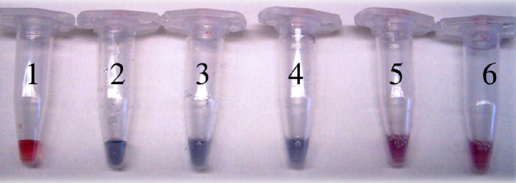
Figure 4. Determination of the optimal NP:r Vu FeSOD ratio: Lines (1) Citrate AuNPs, (2) 1:1 Citrate AuNP:r Vu FeSOD, (3) 1:10 Citrate AuNP:r Vu FeSOD, (4) 1:100 Citrate AuNP:r Vu FeSOD, (5) 1:500 Citrate AuNP:r Vu FeSOD, and (6) 1:1,000 Citrate AuNP:r Vu FeSOD. The lowest amount of protein that maintained a stable colloidal solution after addition of NaCl was selected, corresponding to 1:500 AuNP:r Vu FeSOD (tube